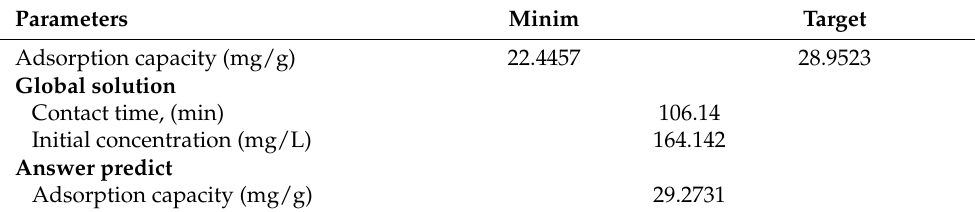
Figure 13. Optimization of the response adsorption process for Phase 2. Table 3. Optimization of the response of the Au (III) adsorption process for Phase 2.